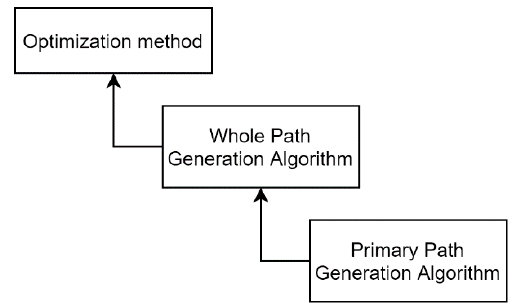
Figure 1. General algorithms hierarchy.